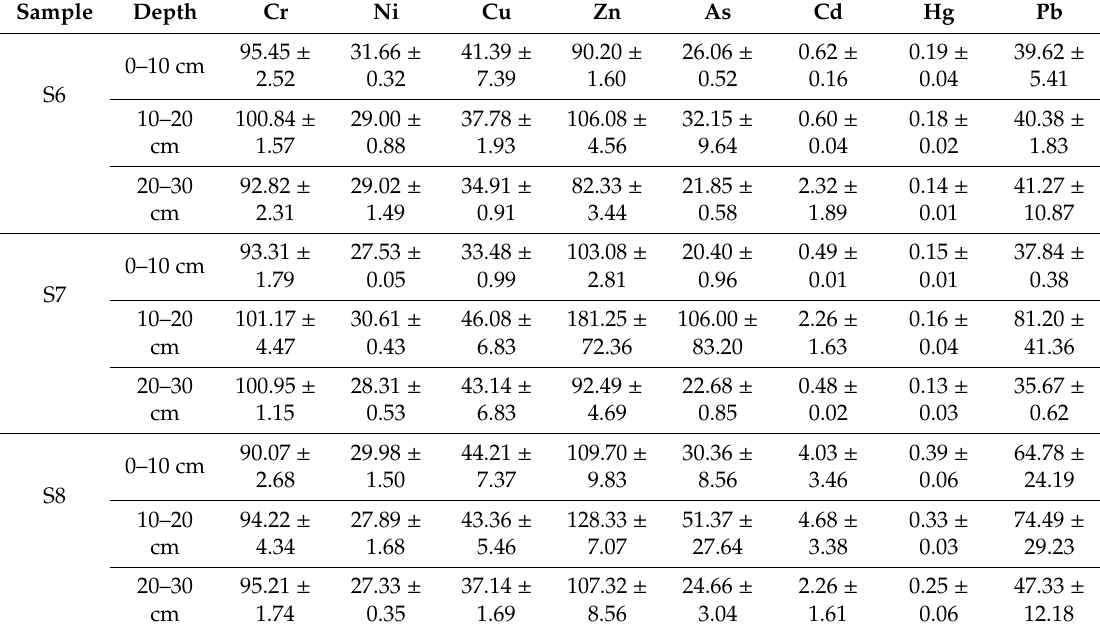
Table 4. Mangrove soil-borne trace elements (mg / kg) in the mid intertidal